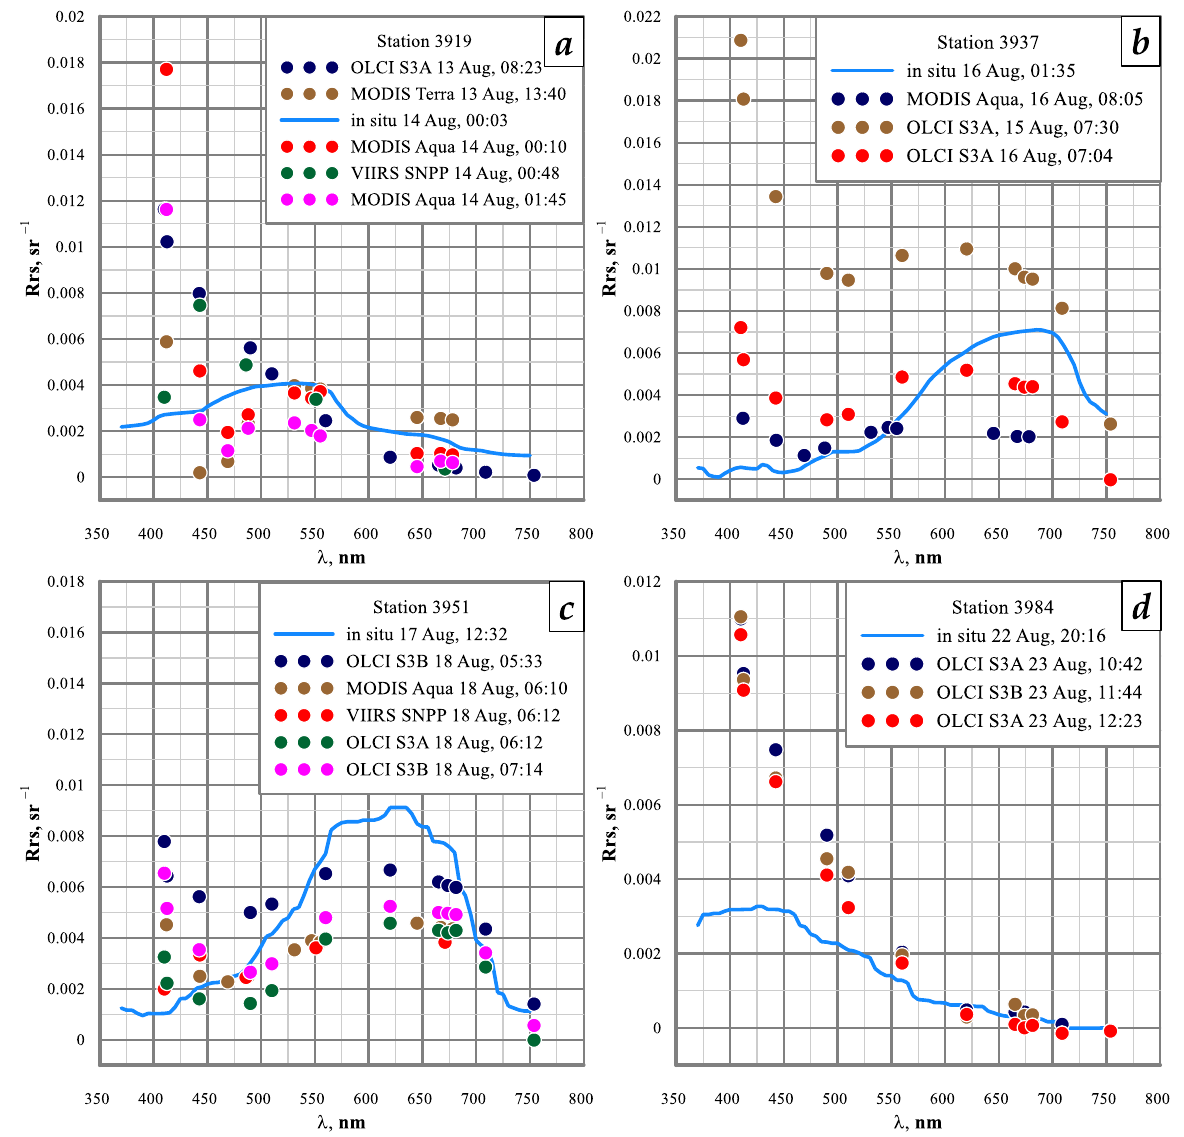
Figure 5. In situ and satellite spectra of remote sensing reflectance for the stations in the central part of the Kara Sea (3919,( a )), Ob Bay (3937,( b )), Yenisey Bay (3951,( c )), and the northern part (3984,( d